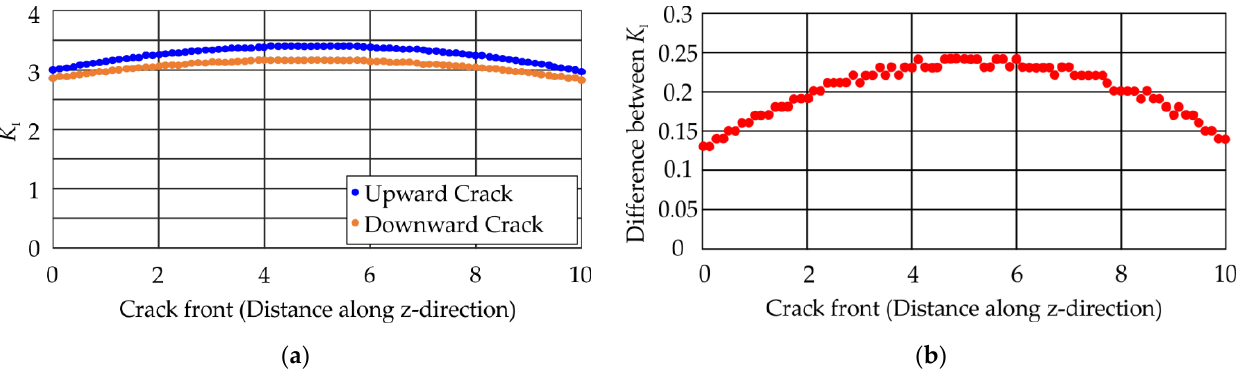
Figure 15. Stress intensity factors calculated by Adapcrack3D for CTS specimens and the difference between the results: ( a ). Stress intensity factors, K I , along the crack fronts for cracks deflected upwards and downwards; ( b ) Difference between the values in Figure 15a along the crack front.